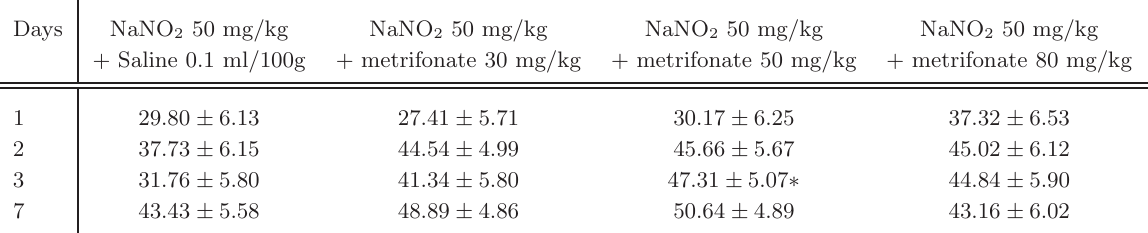
Table 5 Effects of metrifonate on passive avoidance test (step-down) in a model of hypoxia: latency of